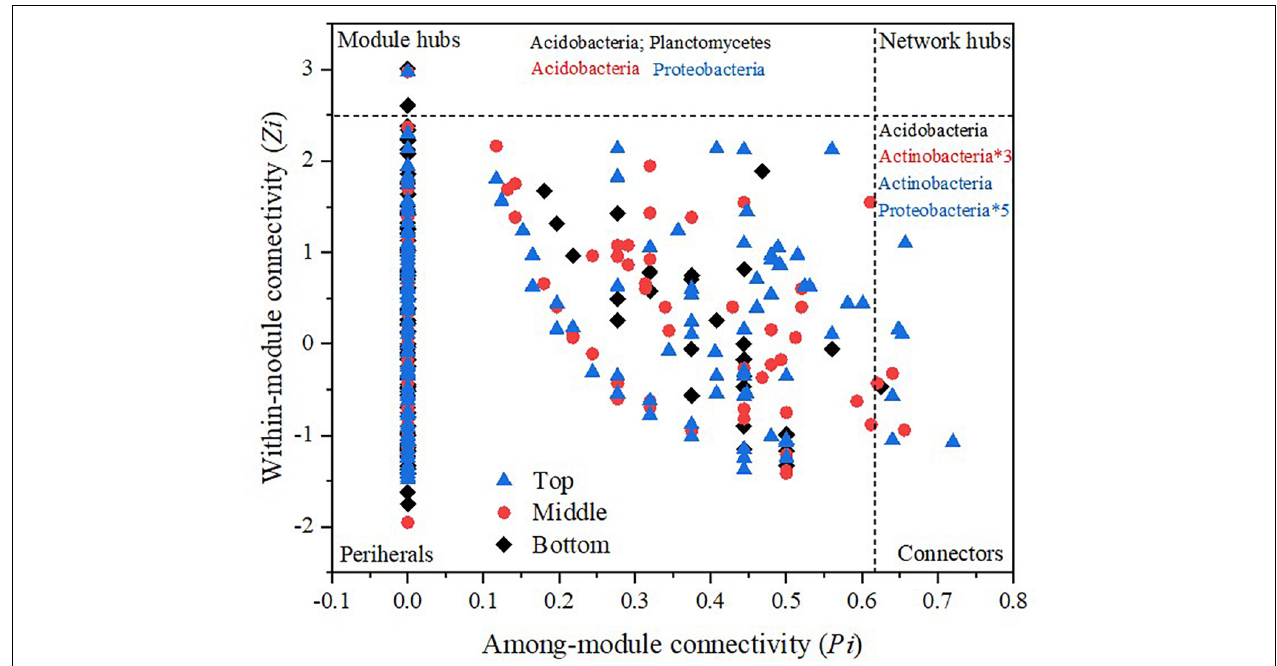
FIGURE 9 | Z-P plot of molecular ecological networks at different locations of the subsidence